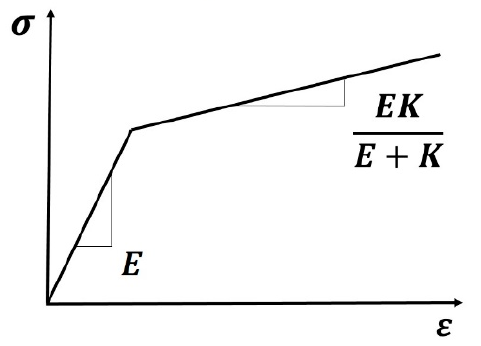
Figure 2. Stress/strain—Kinematic hardening. Figure 2. Stress / strain—Kinematic